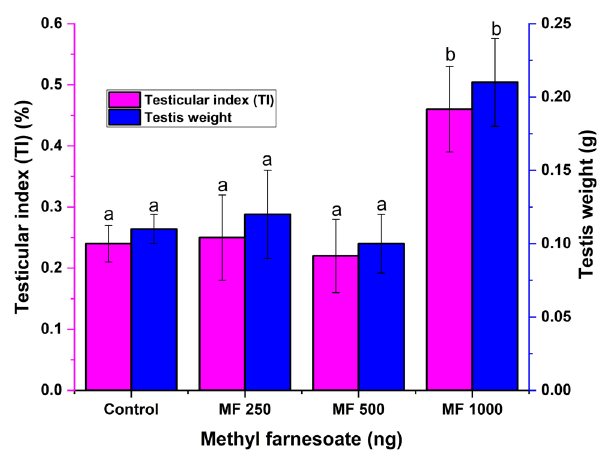
Figure 3. Effect of MF injection on testis weight and TI in male Pontastacus leptodactylus. Letters indicate significant difference groupings ( P < 0.05) (mean ± S.D; n = 15).